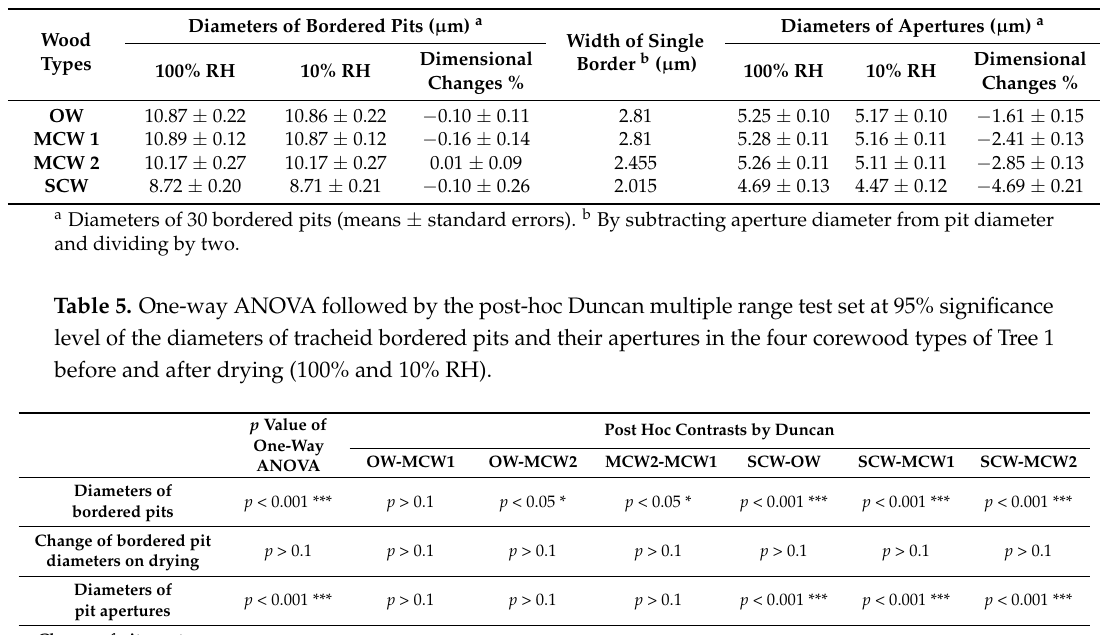
Figure 5. VP-SEM micrographs showing the cut transverse surface of a disc of MCW1 from Tree 1 ( a ) at 100% RH and ( b ) at 10% RH. The chamber (arrow) of the tracheid (T) bordered pits (BP) has collapsed on drying. Scale bar = 20 µ m. Table 4. Diameters of the tracheid bordered pits and their apertures in the four corewood types of Tree 1 before and after drying (100% and 10% RH).